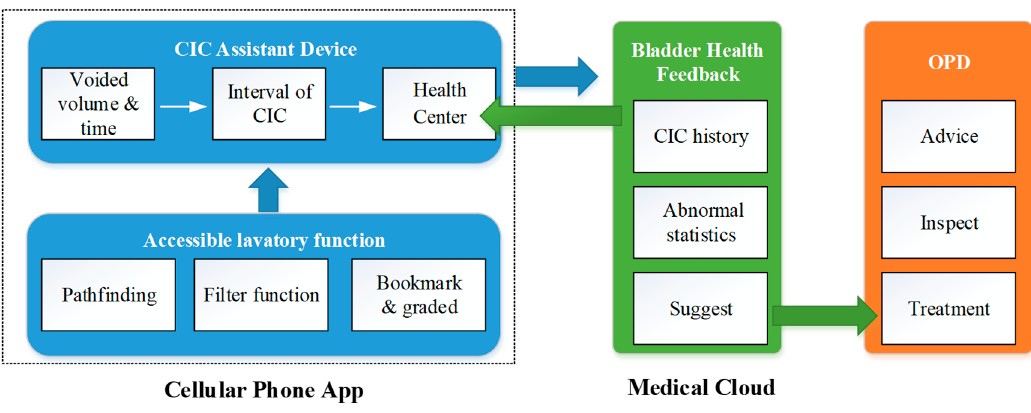
Figure 1. The structure of the personalized assistant system of clean intermittent catheterization (CIC). OPD: outpatient department.